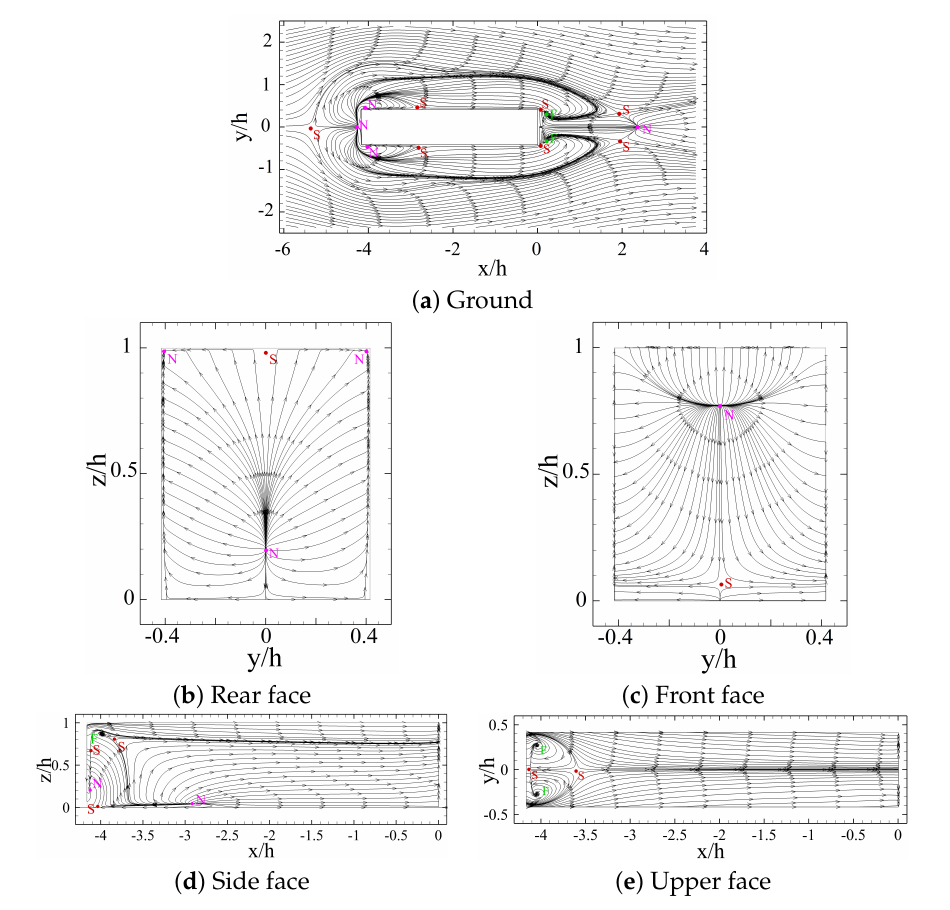
Figure 10. Critical points on the faces of the long